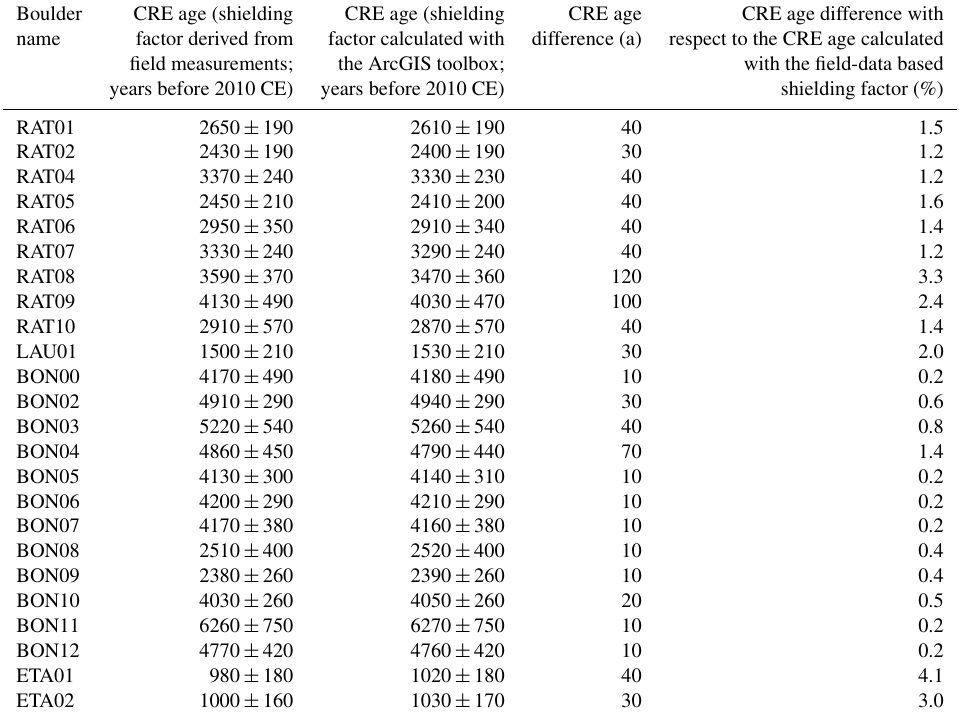
Table B2. Recalculated CRE ages of boulders on terminal moraines of the Rateau (RAT), Lautaret (LAU), Bonnepierre (BON) and Etages (ETA) glaciers in the Écrins massif (Le Roy et al., 2017). In the CREp (Martin et al., 2017), the CRE ages were first calculated with topographic shielding factors derived from field measurements (presented in Le Roy et al., 2017) and subsequently with topographic shielding factors calculated with the ArcGIS-toolbox of Li (2018) and SRTM elevation data (NASA Jet Propulsion Laboratory, 2013).